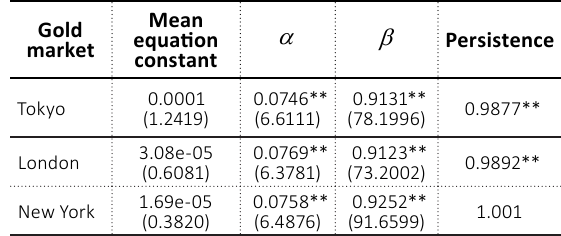
Table 4. Estimation results from DCC-GARCH